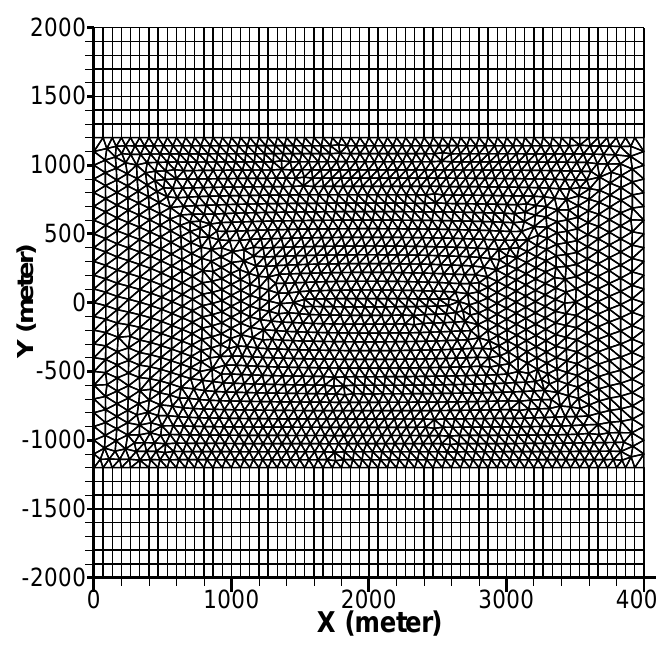
Figure 2. Model domain and the mixed mesh for the